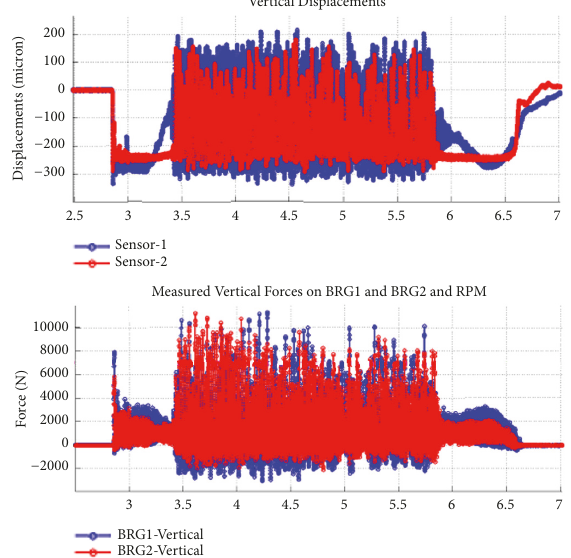
Figure 33: Experimental vertical displacements and forces at DE (blue line) and NDE (red line) rotor